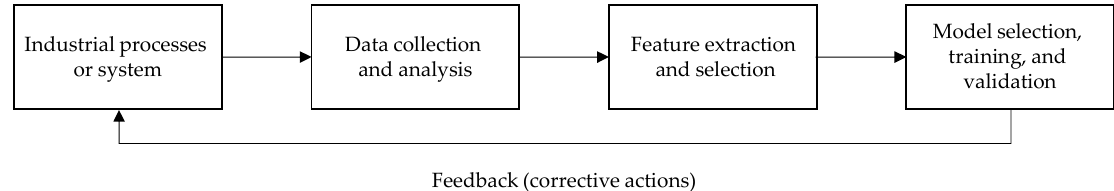
Figure 2. Implementation procedure of a conventional FDD method (or system).